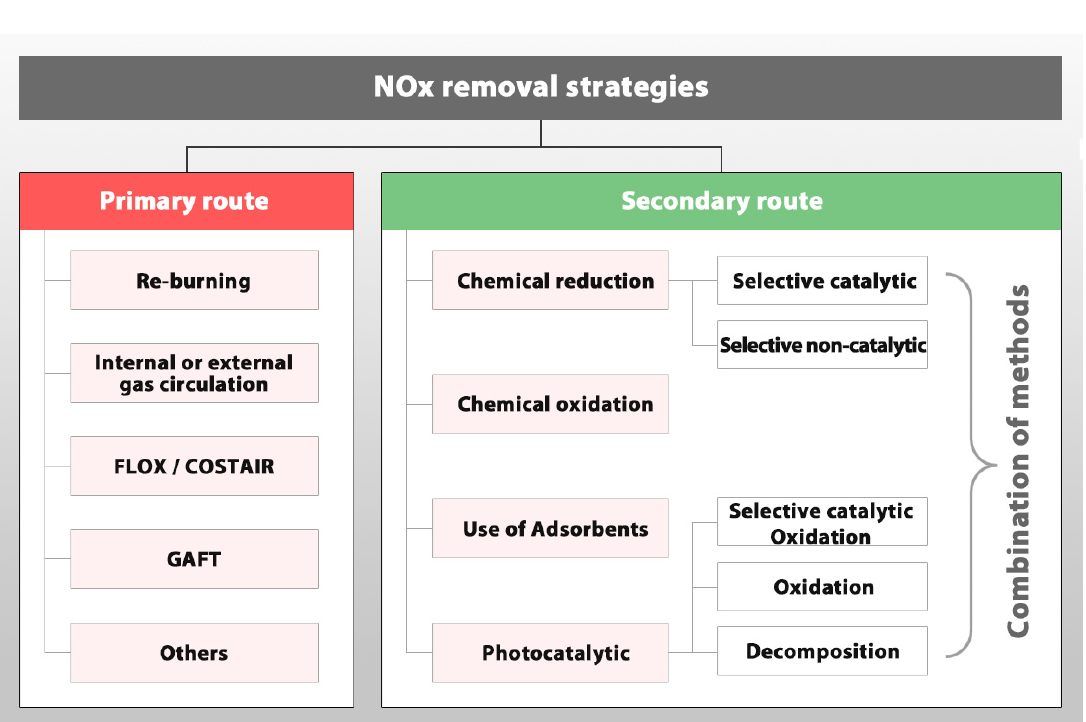
Scheme 5. Common strategies (primary and secondary) employed for NO x removal. (FLOX: flameless oxidation; COSTAIR: continuous staged air combustion; GAFT: gas-dynamic abated flame temperature).